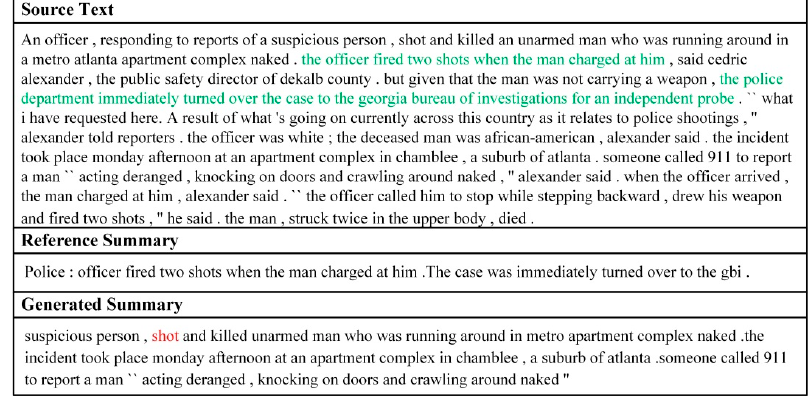
Figure 1. An example of abstractive text summarization. Green font is the key information in the source text. Red font is the key information obtained by current abstractive model.